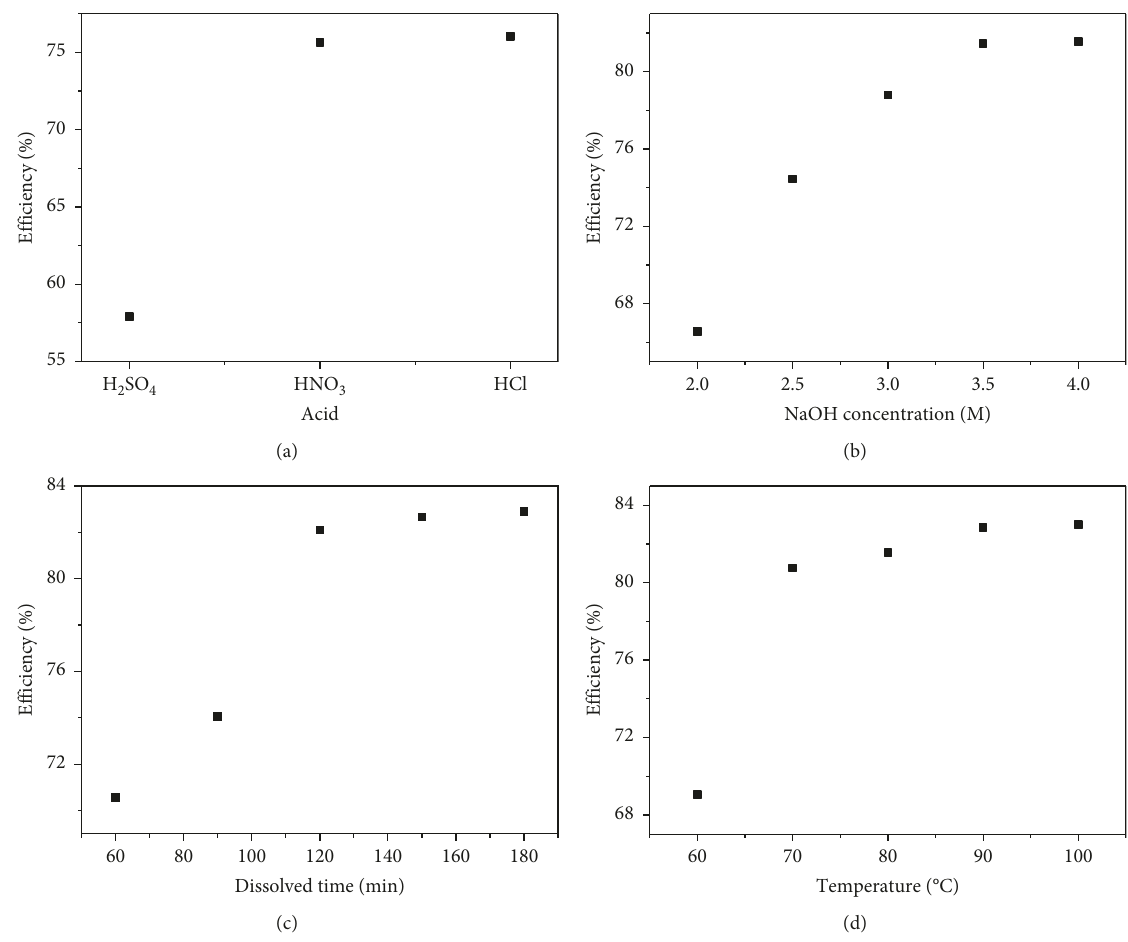
Figure 2: Experimental results of SiO 2 nanoparticles extraction process. Effect of (a) acids, (b) sodium hydroxide, (c) dissolved time, and (d)